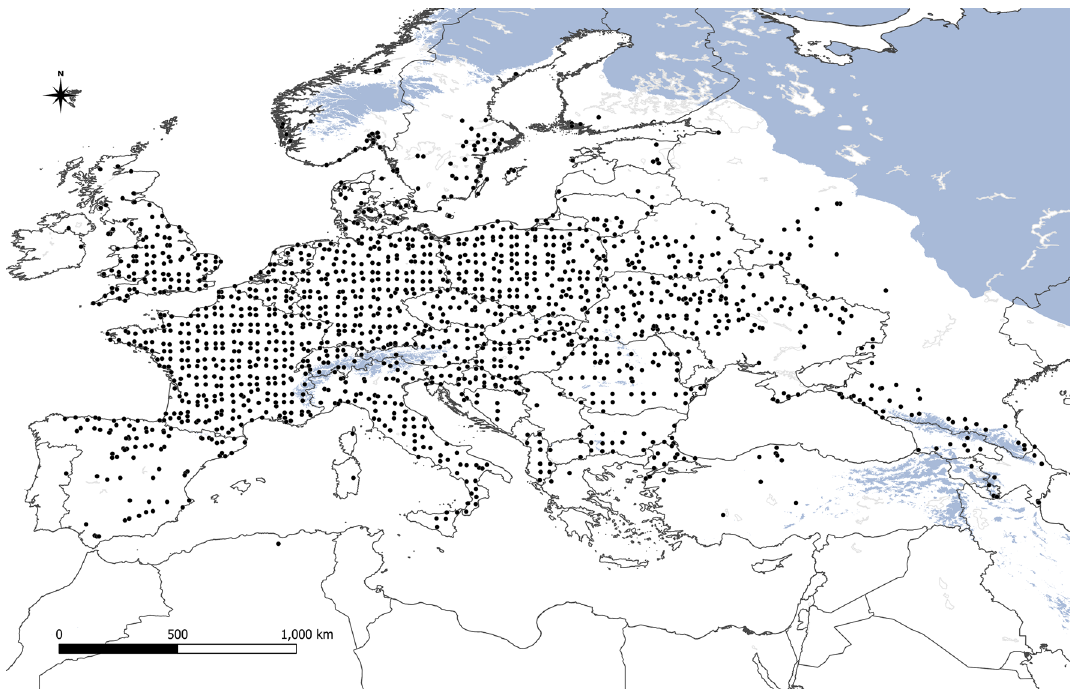
Figure 6. Stands of Viscum album subsp. album used in analyses (black dots). Blue colour indicates areas with average temperature of January below − 8 °C.